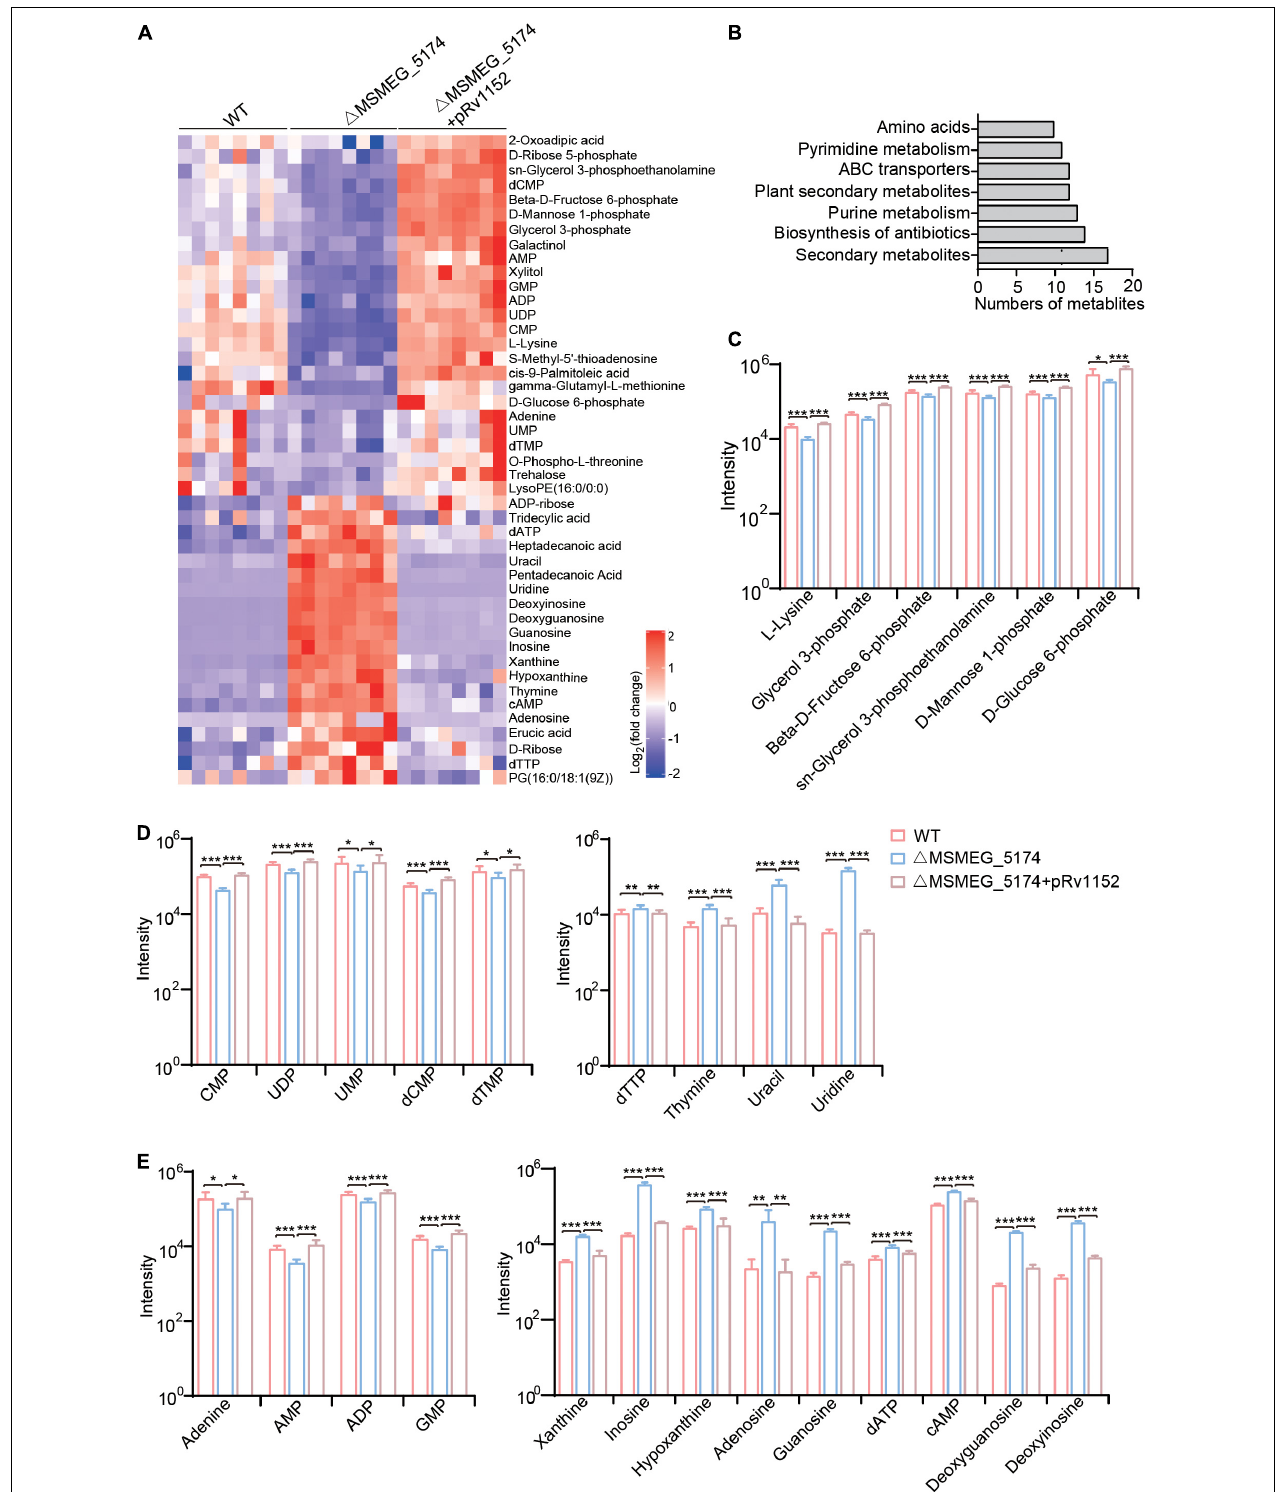
FIGURE 4 | Metabolic profiles of WT, (cid:49) MSMEG_5174 and (cid:49) MSMEG_5174 + pRv1152. (A) Heat map of dysregulated metabolites in WT, (cid:49) MSMEG_5174 and (cid:49) MSMEG_5174 + pRv1152 strains. Map scale (blue to red: low to high abundance). (B) Enriched KEGG pathways in MSMEG_5174 mutants. (C) Dysregulated amino acids and carbon source derived from secondary metabolism. (D) Dysregulated pyrimidine metabolites. (E) Dysregulated purine metabolites. *** P < 0.001, ** P < 0.01, * P < 0.05.